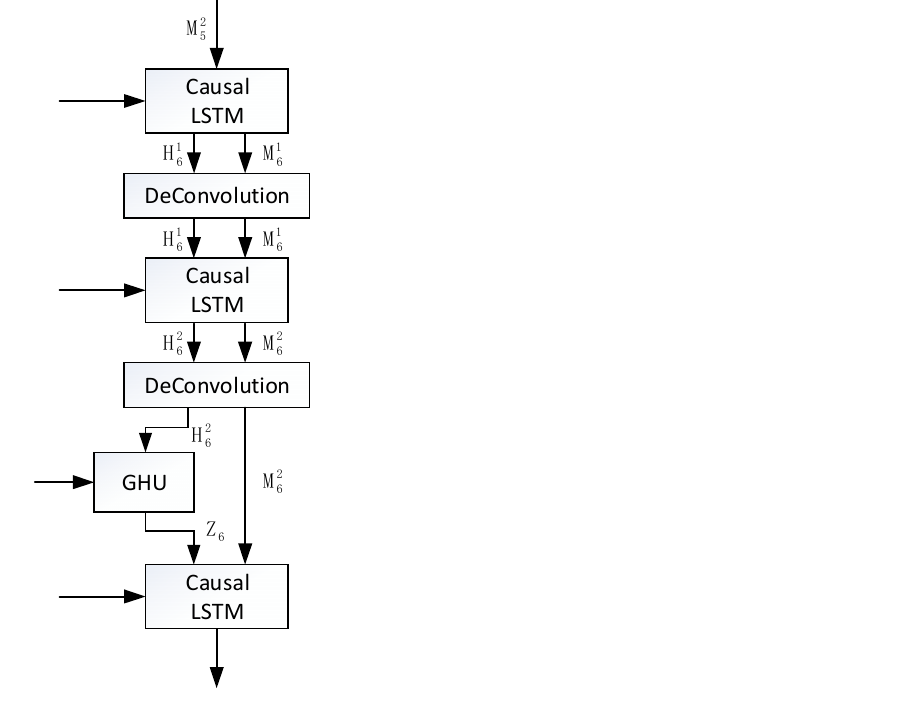
Figure 6. Decoding layer structure.